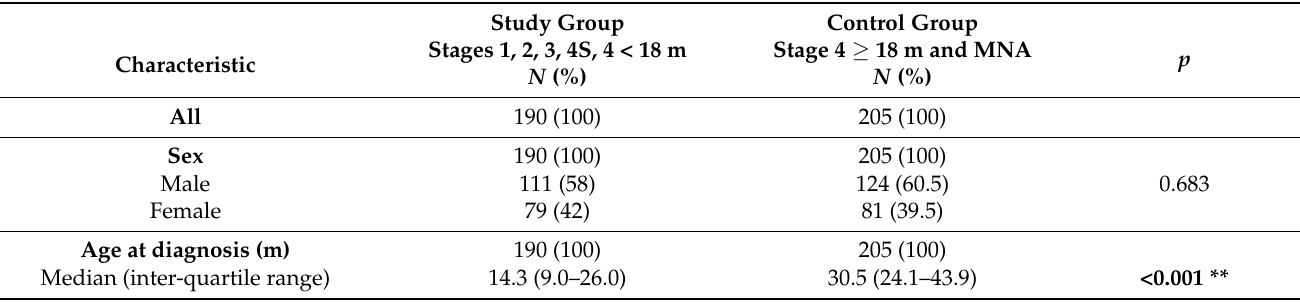
Table 1. Patient